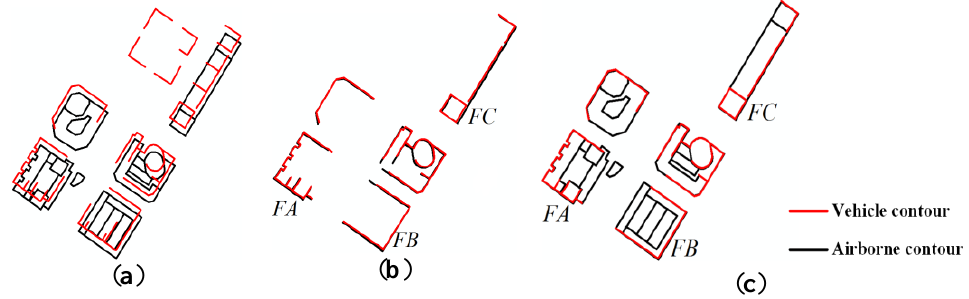
Figure 10. Fine registration with building contours in Area A. ( a ) Result of coarse registration; ( b ) Result after using the conjugate contours; ( c ) Result of fine registration by only using conjugate contours in ( b ), and all airborne contours (black lines) are retained for visualization.